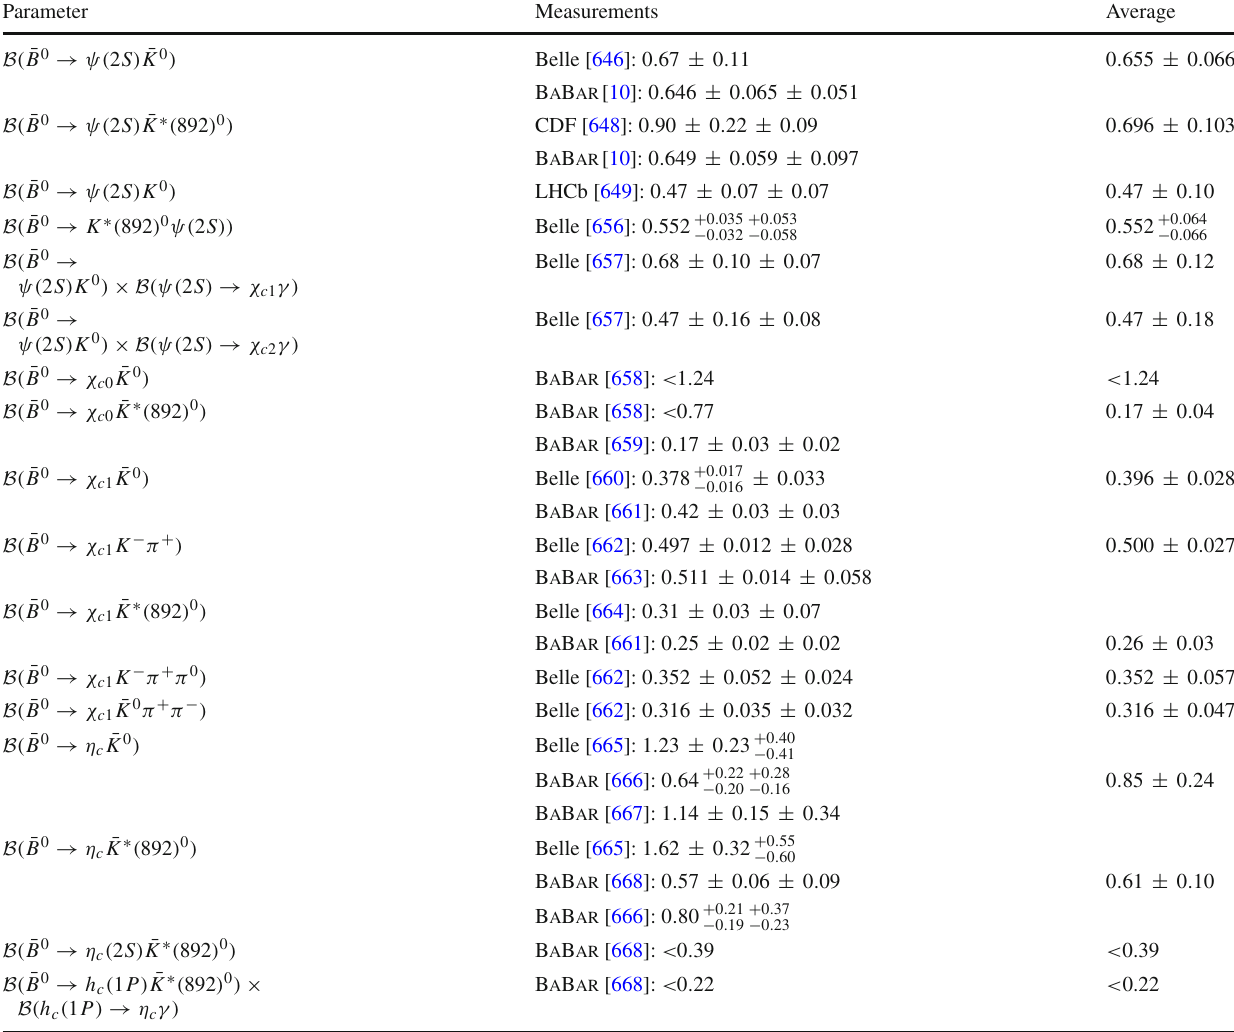
Table 117 Decays to charmonium other than J /ψ and one kaon I [ 10 − 3 ] Parameter Measurements